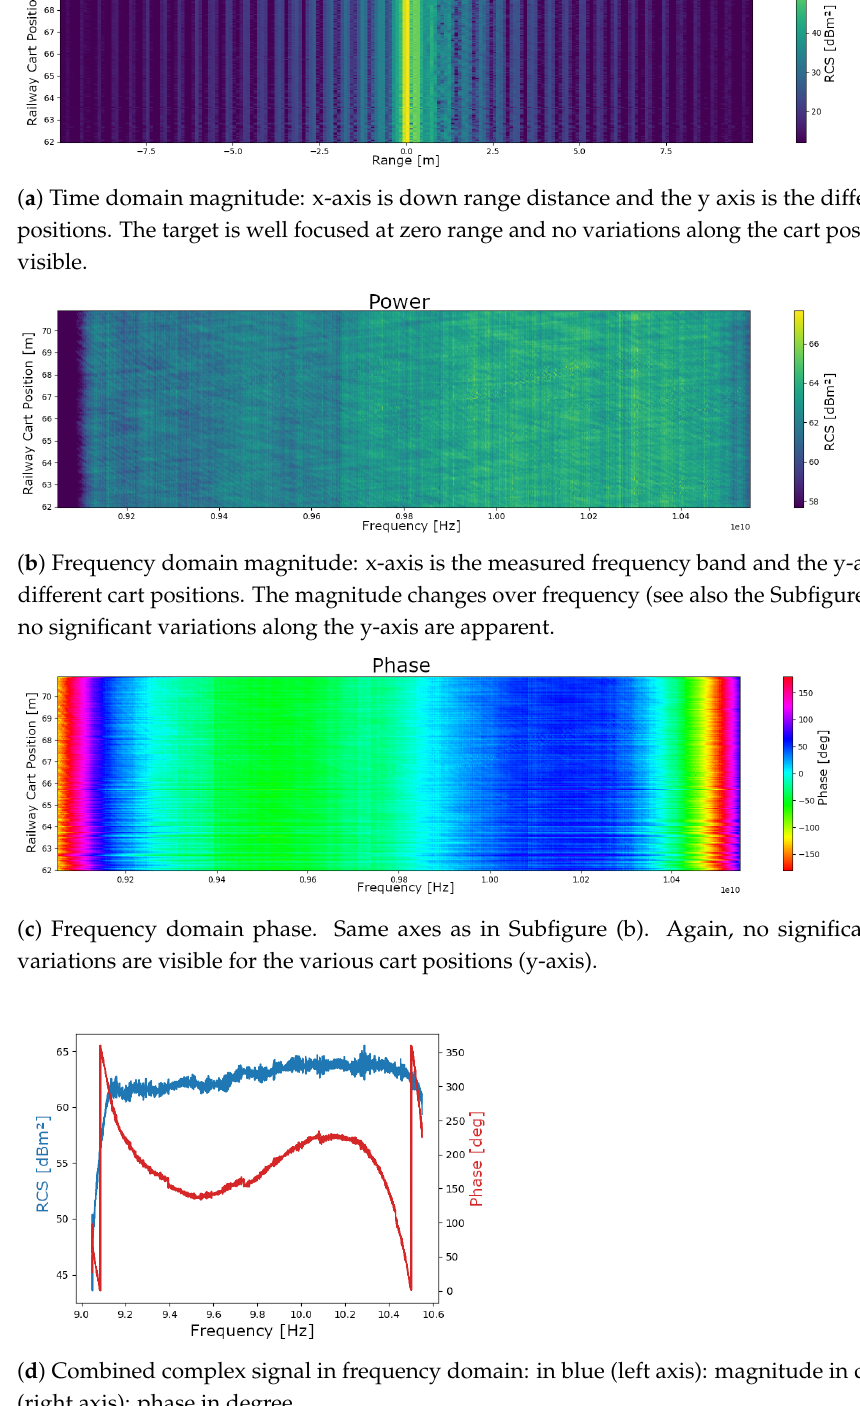
Figure 8. Measurement data from the setup VNA vs. transponder after compensation of known effects, i.e., antenna pattern, free space loss, and target distance, as described in Section 4.3. The measurements for the various railway cart position are shown along the